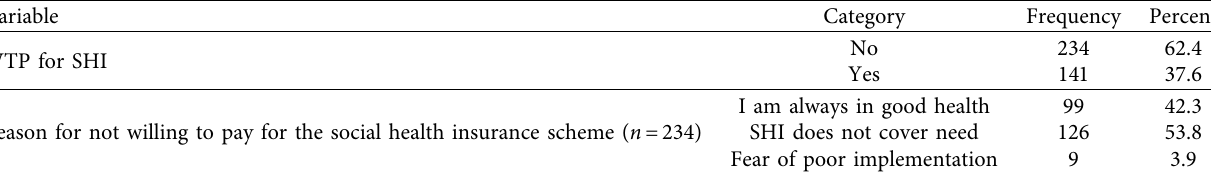
Table 4: Willingness to pay for SHI among government employees in Muja town, northeast Ethiopia, 2016( n � 375).